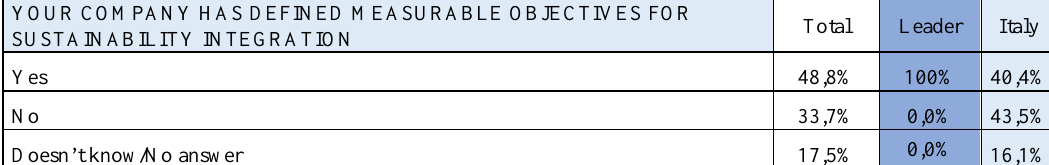
YOUR COMPANY HAS DEFINED MEASURABLE OBJECTIVES FOR SUSTAINABILITY INTEGRATION